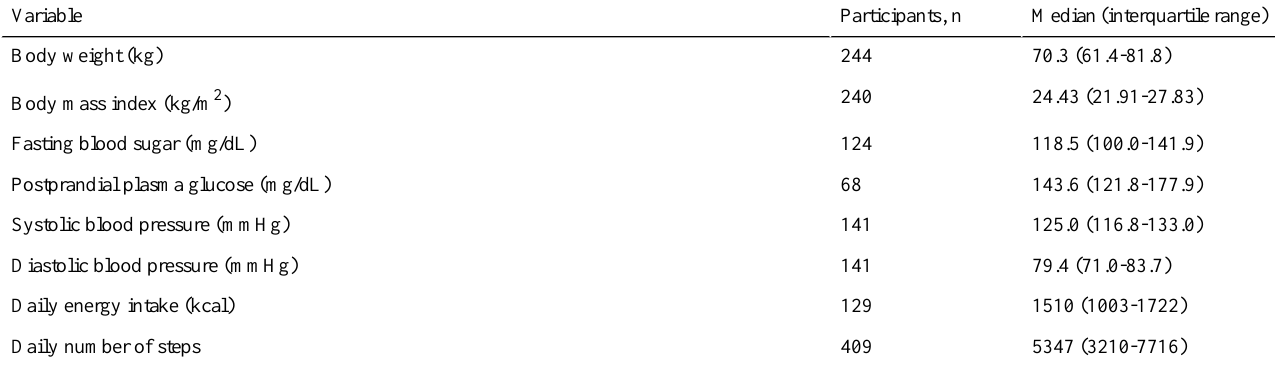
Table 2. Recorded data of participants at week